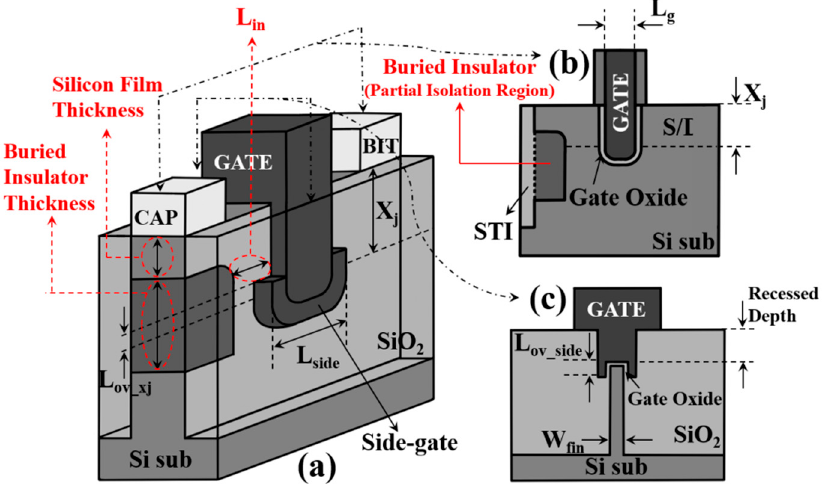
Figure 1. ( a ) 3D schematic view of Pi ‐ FinFET; ( b ) Cross ‐ sectional view across the gate; ( c ) Cross ‐ sectional view of the thin body. The gate wraps three surfaces of the recessed channel, similar to a FinFET. The buried insulator material is used with SiO 2 below the storage node. The buried insulator is penetrated from the shallow trench isolation (STI) region. The X j of the source/drain (S/D) is located 112 nm from the top surface of the S/D region with a Gaussian profile. The peak concentration of the S/D Gaussian doping profile is 1.5 × 10 20 cm − 3 , and the uniform body doping concentration is 5 × 10 17 cm − 3 .